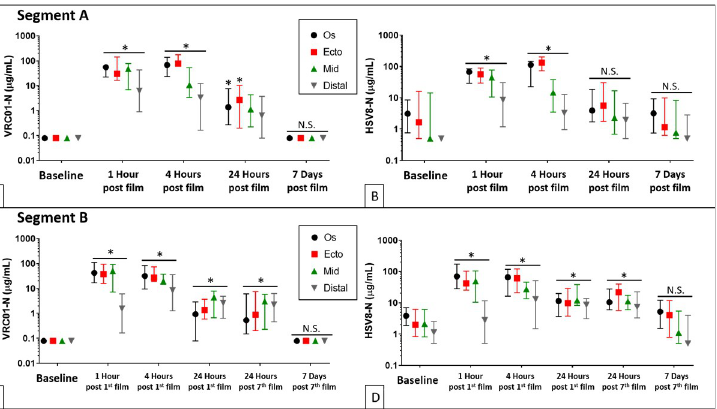
Fig 4. VRC01-N and HSV8-N concentrations (represented by medians with interquartile ranges) in cervicovaginal TearFlo samples in Segments A and B (Active film group only). ( A). Segment A, VRC01-N: All 4 sites significantly elevated at 1 hour ( p < 0.001 for all site comparisons) and 4 hours ( p < 0.001 for cervical os, ectocervix, and mid vagina sites; p = 0.007 for distal vagina) post single film insertion compared to respective baseline concentrations. Cervical os ( p = 0.046) and ectocervix ( p = 0.02) were elevated 24 hours post film insertion. Mid ( p = 0.09) and distal vagina ( p = 0.54) were not significantly elevated 24 hours post film insertion. ( B). Segment A, HSV8-N: All sites were significantly elevated at 1 hour and 4 hours post single film insertion ( p < 0.001 for all comparisons) but not at the 24-hour time point. ( C). Segment B, VRC01-N: All 4 sites were significantly elevated at 1 ( p < 0.001 for all site comparisons) and 4 ( p < 0.001 for all site comparisons) hours following first film insertion compared to each site’s respective baseline concentration. Concentrations at all 4 sites 24 hours after first film and 24 hours after seventh film remained significantly elevated compared to Baseline ( p < 0.001 for distal vagina, ectocervix, and mid vagina sites and p = 0.01 for cervical os for Baseline vs. 24 hours post first film, and p < 0.001 for distal vagina, ectocervix, and mid vagina sites and p = 0.0007 for cervical os for Baseline vs. 24 post seventh film). ( D). Segment B, HSV8-N: All 4 sites were significantly elevated at 1 and 4 hours following first film insertion compared to Baseline concentrations. Concentrations at all 4 sites at 24 hours after first film and 24 hours after seventh film remained significantly elevated compared to Baseline ( p < 0.001 for all